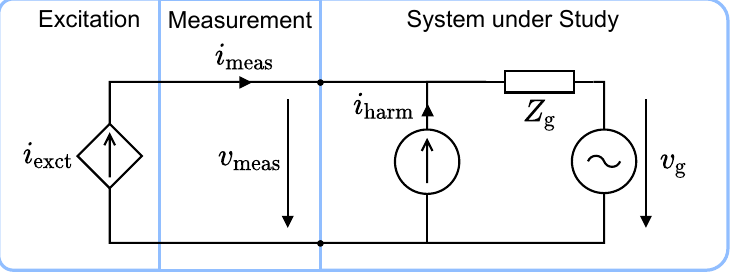
Figure 14. Realistic impedance measurement scenario in which the power grid is disturbed by